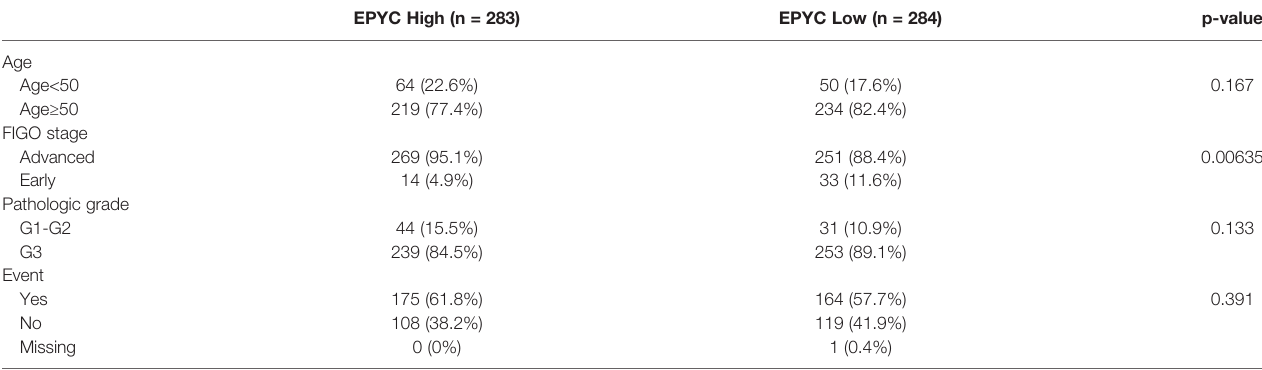
TABLE 2 | Expression of EPYC with clinicopathological parameter of ovarian cancers from the TCGA